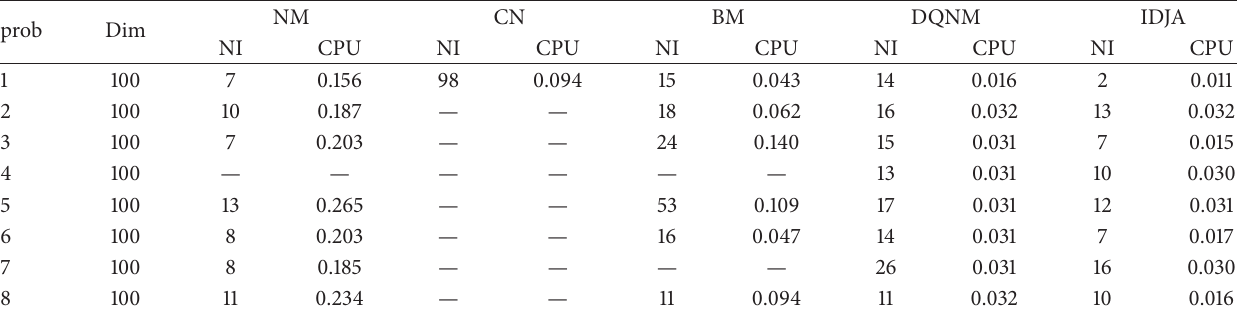
Table 2: Numerical Results of NM, CN, BM, DQNM, and IDJA methods.